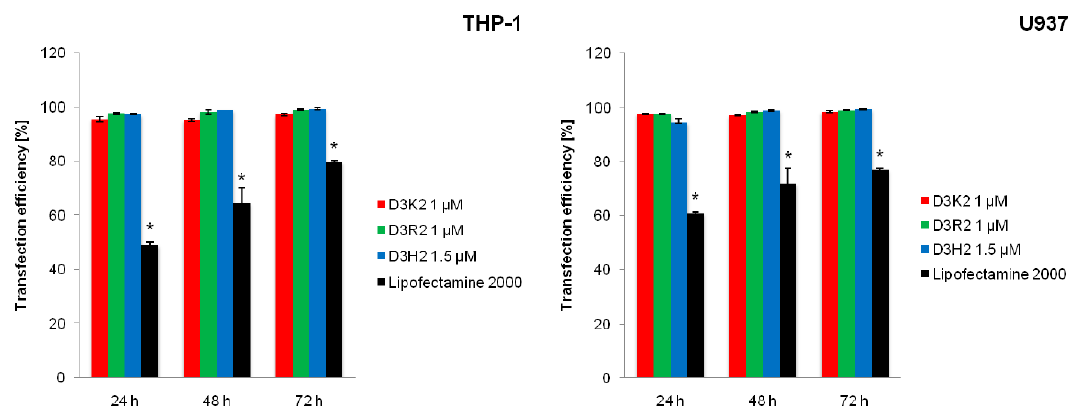
Figure 5. Efficiency of cellular uptake of siRNA-FITC by THP-1 and U937 cells (average ± SD, n = 3). The dendrimer:siRNA molar ratios equaled 20:1 (D3K2, D3R2) and 30:1 (D3H2). * Statistically significant difference between dendriplexes and Lipofectamine 2000:siRNA complex at p < 0.05.